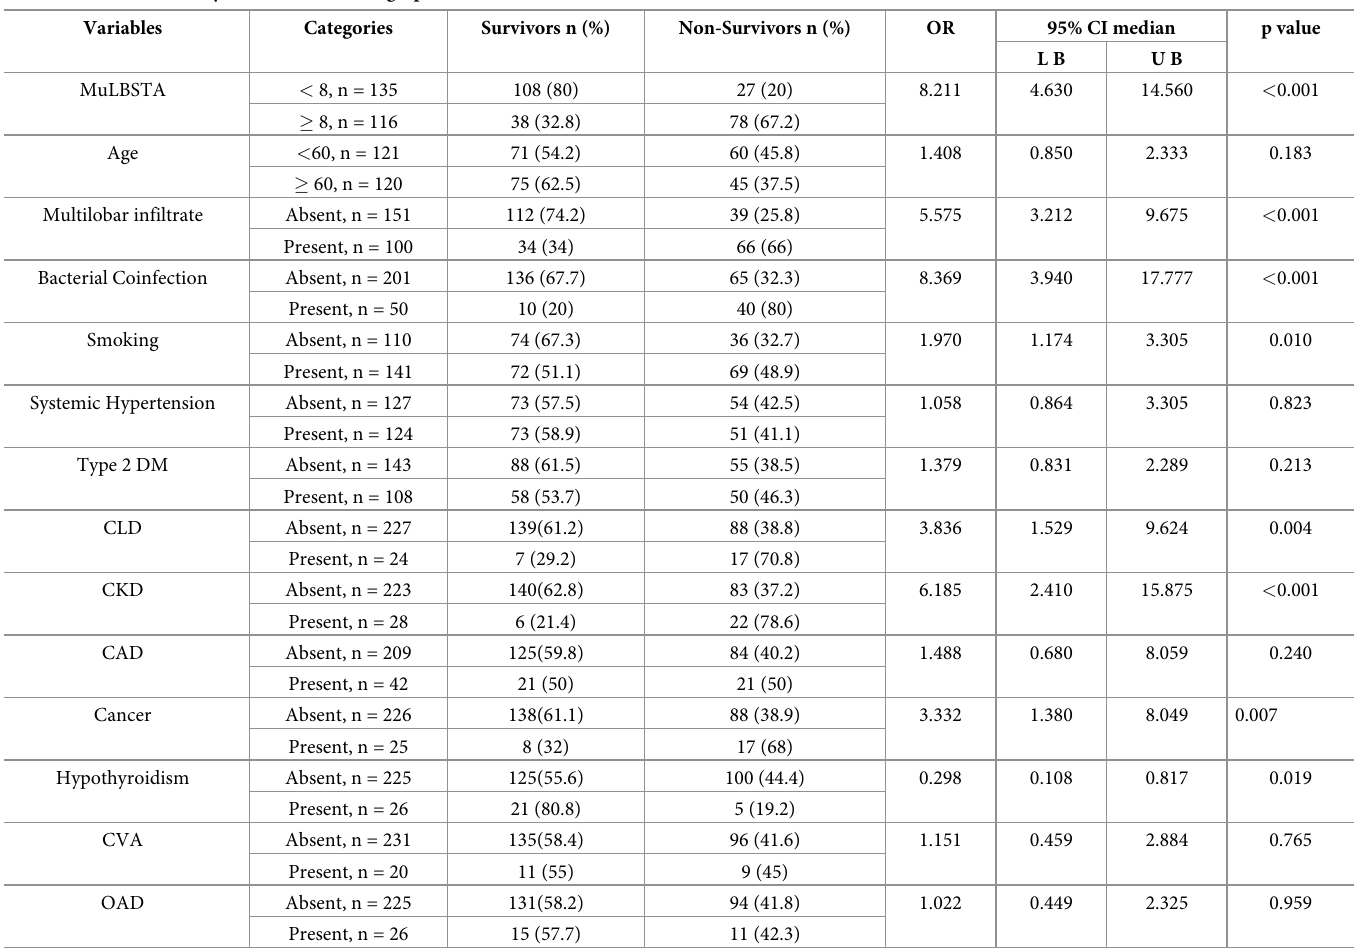
Table 1. Uni-variate analysis of baseline demographics and